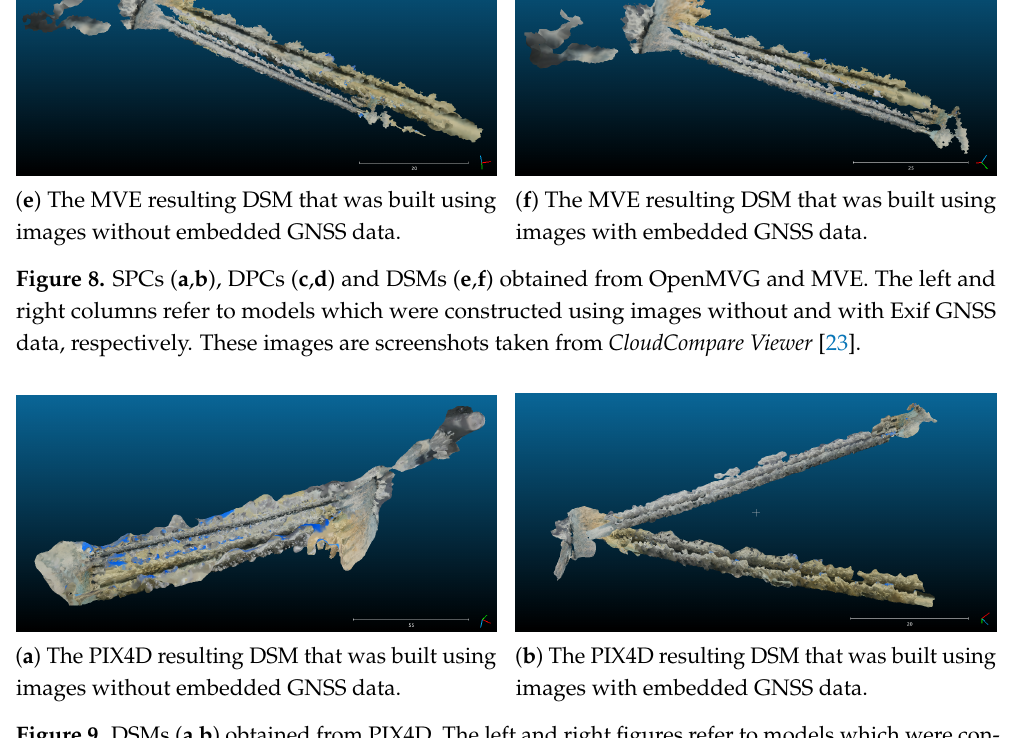
Figure 9. DSMs ( a , b ) obtained from PIX4D. The left and right figures refer to models which were con- structed using images without and with Exif GNSS data, respectively. These images are screenshots taken from CloudCompare Viewer